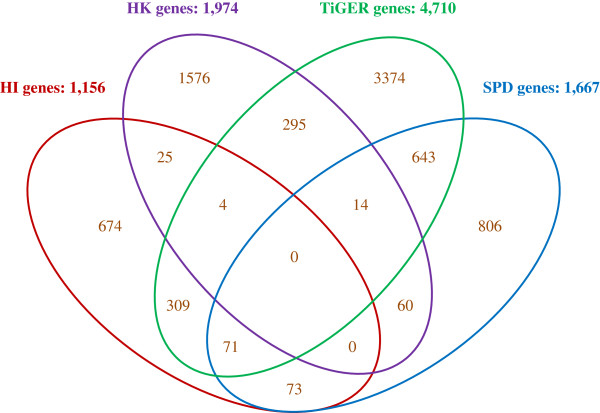
Venn diagram of the overlap between and among four datasets. Gene datasets are colored according to gene classes (HI genes, HK genes, TiGER genes and SPD genes), and the total gene number is shown beside the dataset name. The unique and shared gene numbers between and among the four gene datasets are shown in the unique and overlapped regions.